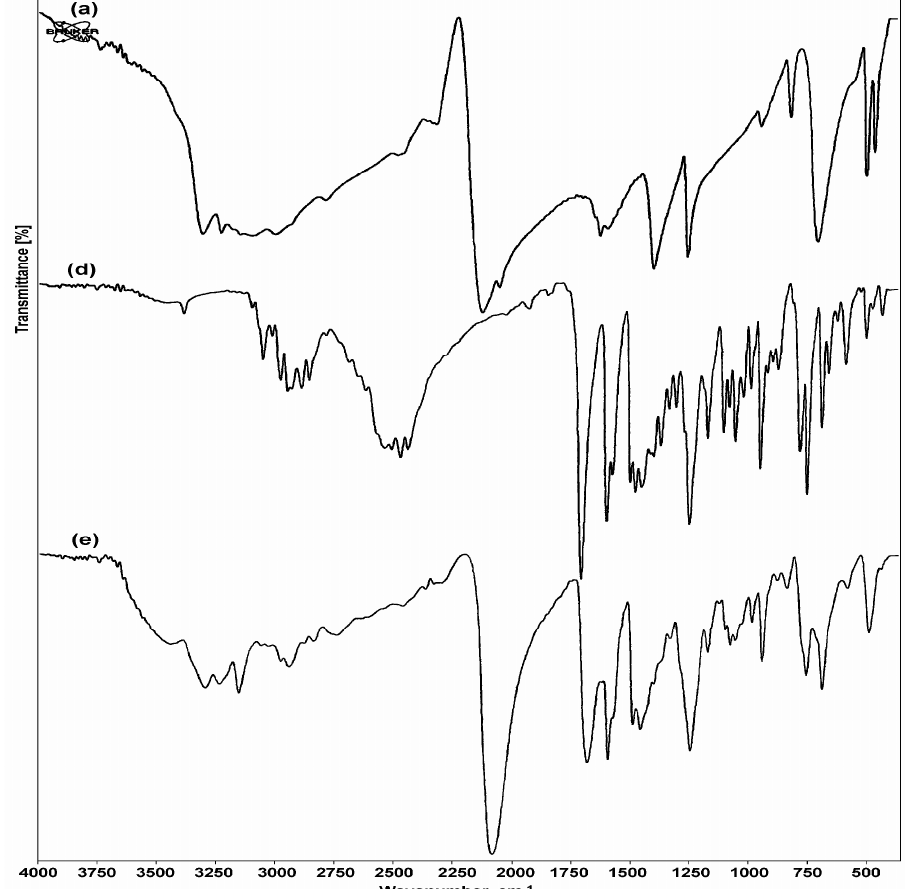
Figure 7. IR spectra of (a) ammonium reineckate, (d) Nefazodone HCl, and (e) Nefazodone HCl and ammonium reineckate